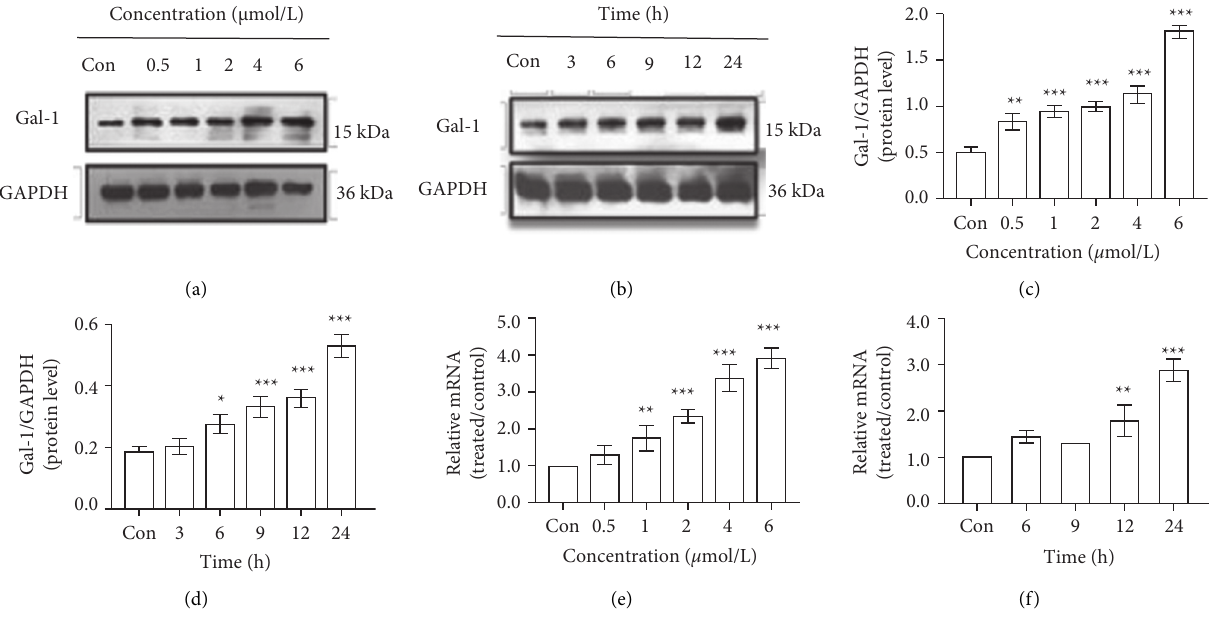
Figure 5: Effects of DBDCT on Gal-1 expression in HL7702 cells. (a) Immunoblotting results for 24h. (b) Immunoblotting results with 2 μ mol/L DBDCT. (c) Relative protein level for 24h. (d) Relative protein level with 2 μ mol/L DBDCT. (e) Relative mRNA level for 24h. (f) Relative mRNA level with 2 μ mol/L DBDCT. Results were normalized according to GAPDH level. Each value represents the mean ± SD of three independent experiments. ∗ p < 0 . 05, ∗∗ p < 0 . 01, and ∗∗∗ p < 0 . 001 compared with the control